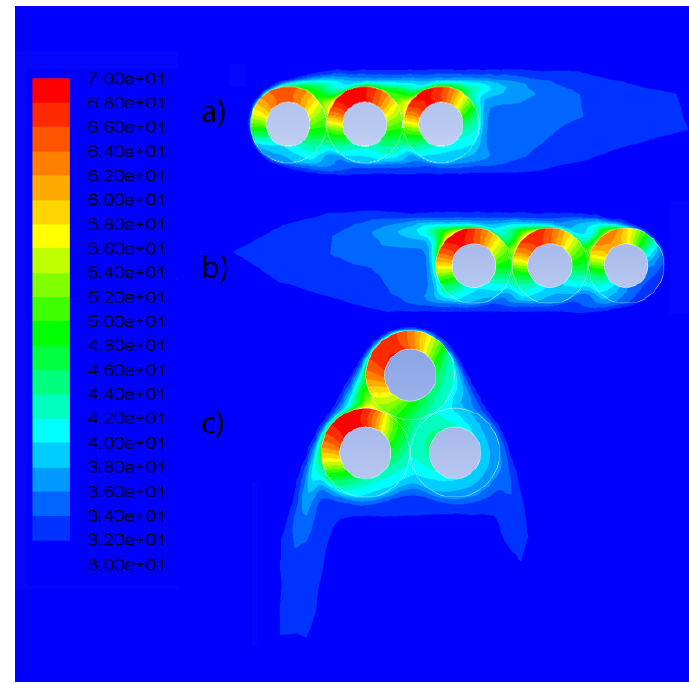
Figure 7. Temperature distribution (°C) for wind speed (1 m/s) in the: ( a ) South–North direction (from the left to the right side); ( b ) North–South direction (from the right to the left side); ( c ) Top–Bottom direction [30].